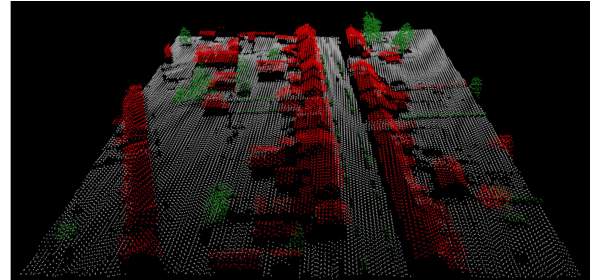
Figure 2. Visualization of an urban model CityJSON in point cloud only (33.811